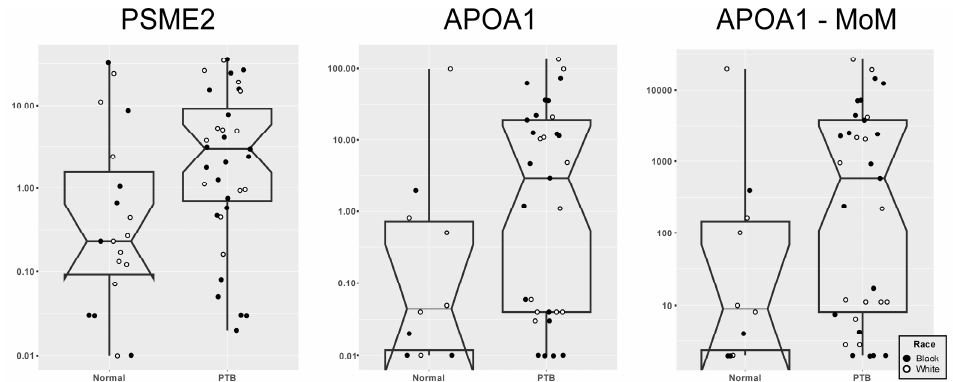
Figure 1. Expression Levels in Plasma Cell-Free PSME2 and APOA1 —cases and controls. Boxplots showing differentially expressed RNAs, e.g., PSME2 (with maternal age), APOA1 , and APOA1 MoM. The boxes indicate the median and first and third quartiles, the lines demark the 10th and 90th percentile of the distributions, and the notches in the bars indicate median ± 1.57 * interquartile range/Sqrt (n). The overlying circles indicate individual patient’s data, and these circles are coded by race. Nonoverlapping notches are “strong evidence” the medians differ. The folding of the box back towards the notch indicates a skewed distribution. Any sample outside whiskers might be an outlier. Footnote: Graphs created in R using ggplot2 library and the geom_boxplot() method (contact authors for the script).